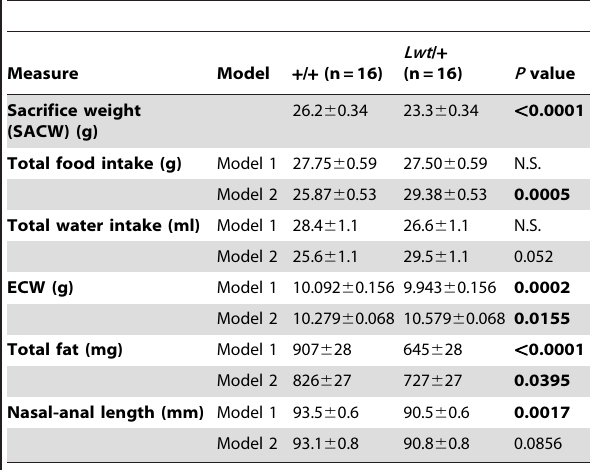
Model 1: unadjusted raw data. Model 2: sacrifice weight included as covariate. ECW, empty carcass weight (a measure of lean body mass).